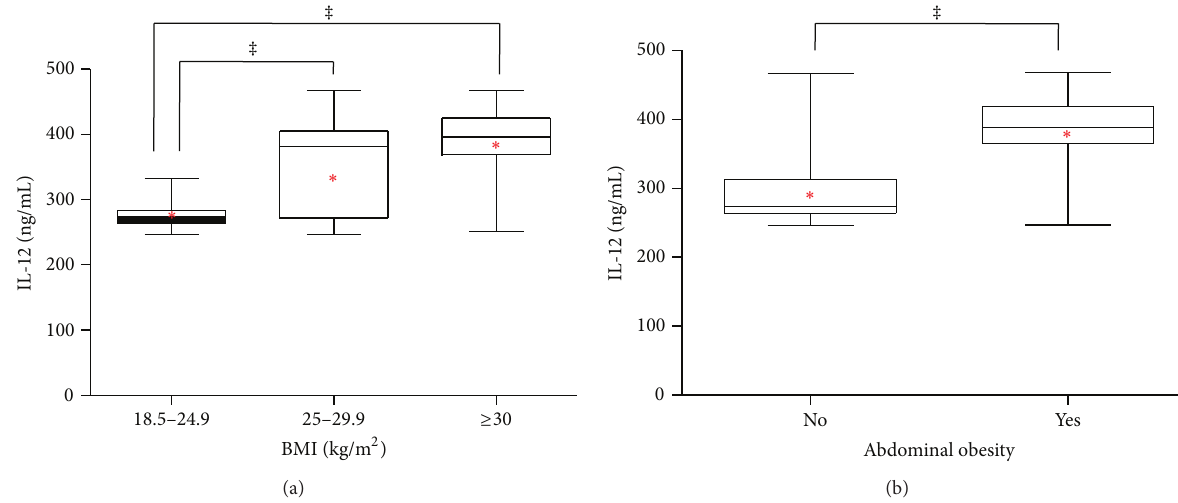
Figure 1: Serum levels of IL-12 in obese and nonobese individuals. Circulating levels of IL-12 (a) were assessed in normal weight, overweight, and obese subjects, according to the World Health Organization criteria for body mass index (BMI). In the study population, serum concentrations of IL-12 (b) were also evaluated in terms of abdominal obesity. Serum IL-12 was elevated in overweight and obese individuals, as well as in subjects exhibiting abdominal obesity. For women, abdominal obesity was considered when the waist measurement was 88cm or higher, whereas for men, it was considered when the waist measurement was 102 cm or higher. Data are expressed as median and interquartile range in a box plot analysis. The mean value of IL-12 is graphically showed in a red asterisk. Differences were considered significant when 𝑃 < 0.05. ‡ 𝑃 < 0.0001